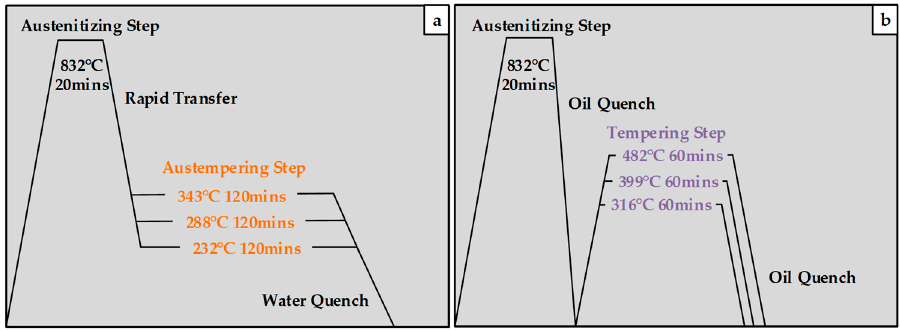
Figure 2. Heat Treatment Processes: ( a ) Austempering; ( b ) Quench-Tempering.